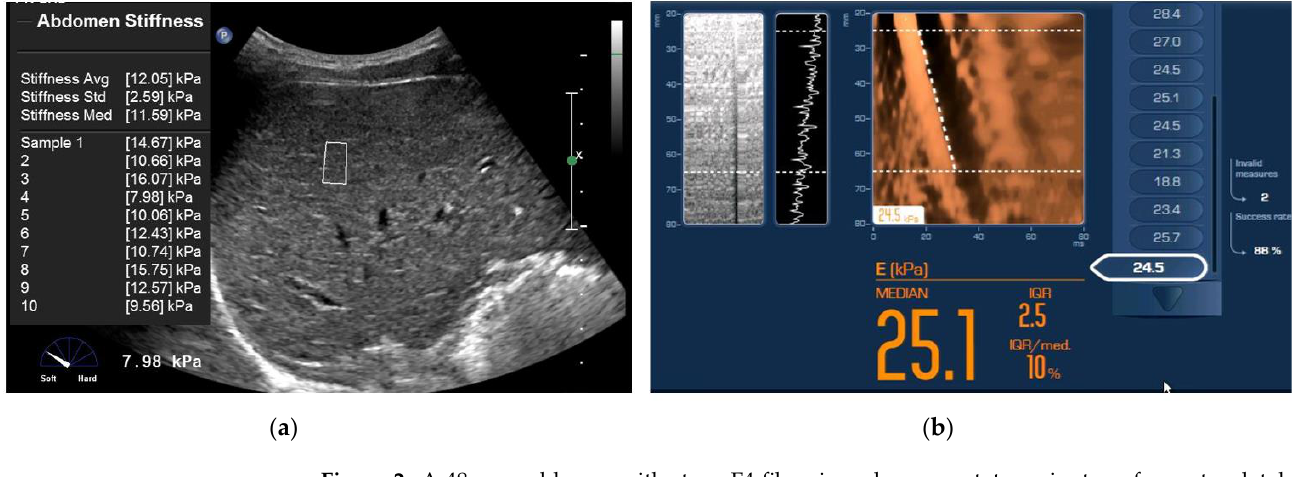
Figure 2. A 48-year-old man with stage F4 fibrosis and an aspartate aminotransferase-to-platelet ratio index of 1.24. Liver stiffness measurement (LSM) using ElastPQ ( a ). The value measured using ElastPQ is shown at the bottom left. The median value is 11.59 kPa. On the transient elastography image, the median LSM was 25.1 kPa ( b ).